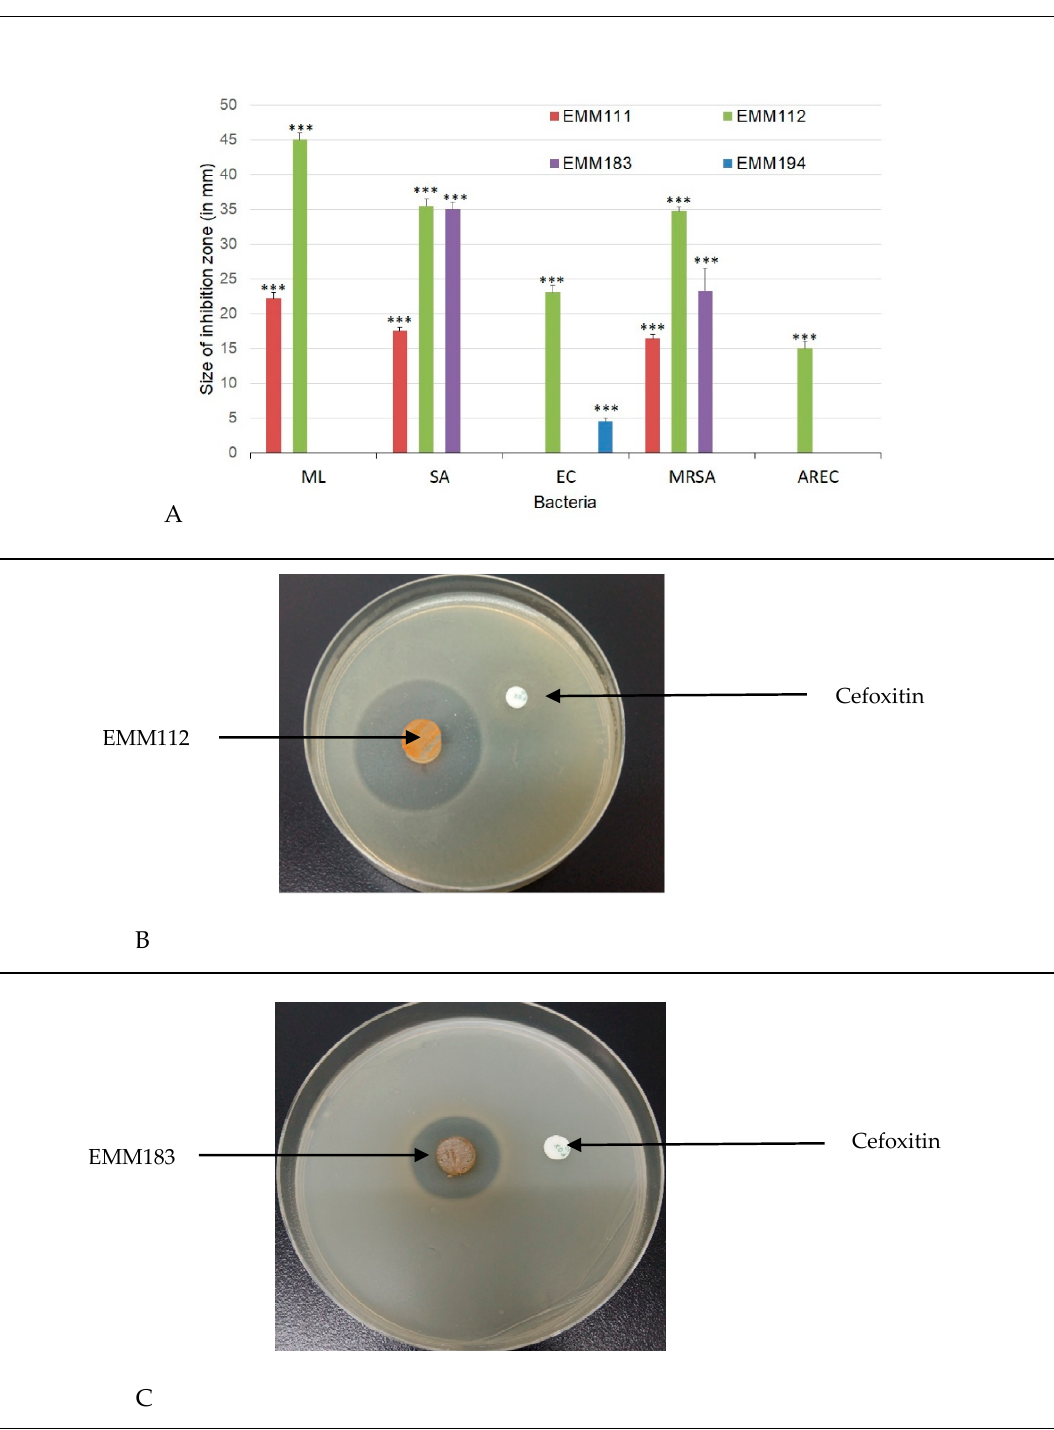
Figure 4. ( A ): Comparative bar graph showing the size of inhibition zones in mm for the four non-obligate predatory Actinobacteria using Bennett medium against di ff erent bacteria. Each value represents the mean ± SD of three replicates; *** p < 0.001 indicates significant di ff erences compared the agar cylinders of Bennett medium using two-way analysis of variance (ANOVA). ML: M. luteus, S: Staphylococcus aureus, EC: Escherichia coli , MRSA: methicillin-resistant S. aureus , AREC: ampicillin-resistant E. coli ; ( B ): Antibacterial activity of EMM112 using Bennett medium against MRSA; ( C ): Antibacterial activity of EMM183 using Bennett medium against MRSA.